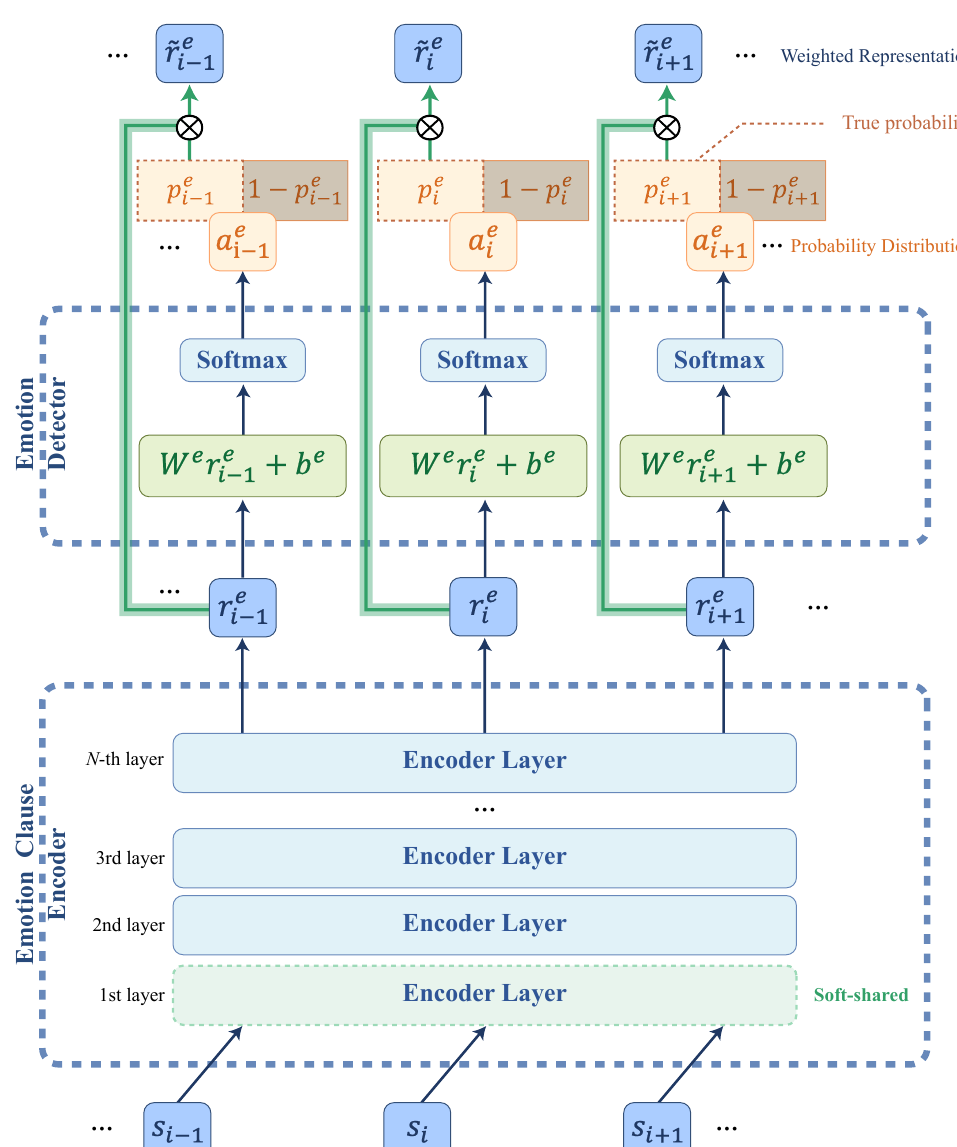
Figure 3. Implementation details of the weighted representation. The weighted representation of the cause clause is similar to that of the emotion clause, thus it is omitted here. s i − 1 , s i and s i + 1 are the clause representation output by the word-level encoder. r e representations of corresponding